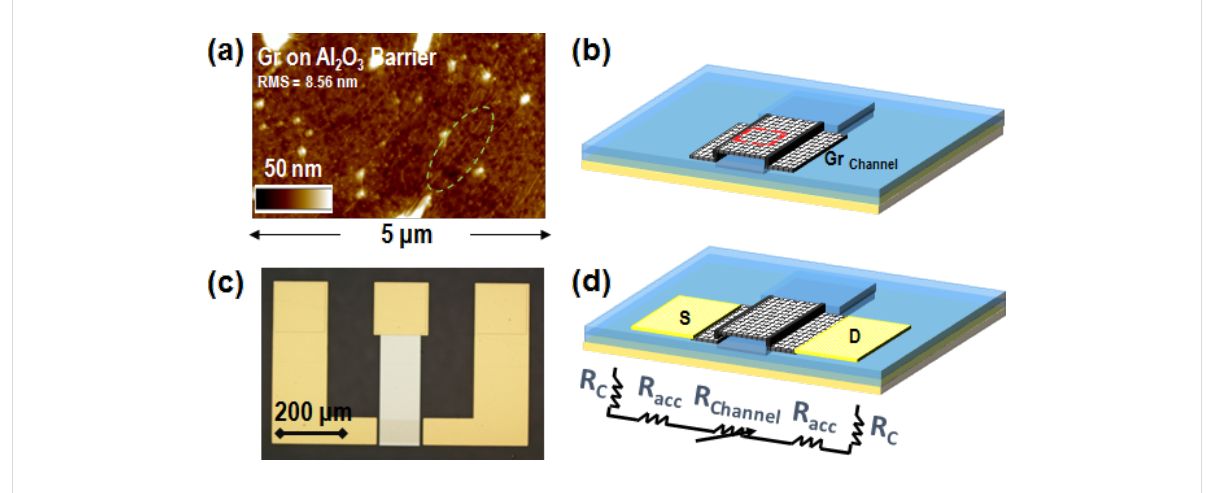
Figure 4: a) Tapping mode atomic force microscopy (tAFM) morphology and b) schematic illustration of the graphene channel. c) Optical microscopy and d) schematic illustration of the final back-gated device with the detail of the involved series resistance contributions from source to drain.